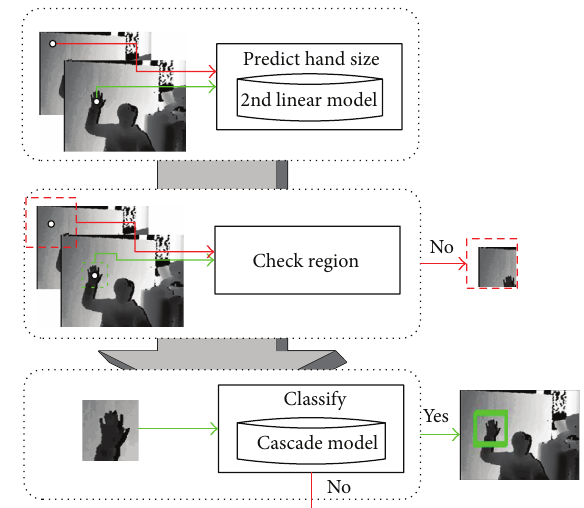
Figure 6: Process of hand region